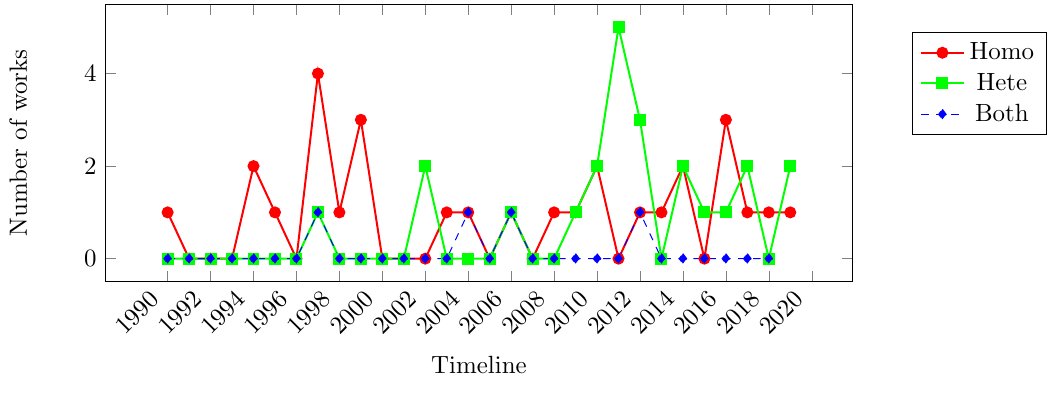
Figure 3. Timeline of the computational environment.